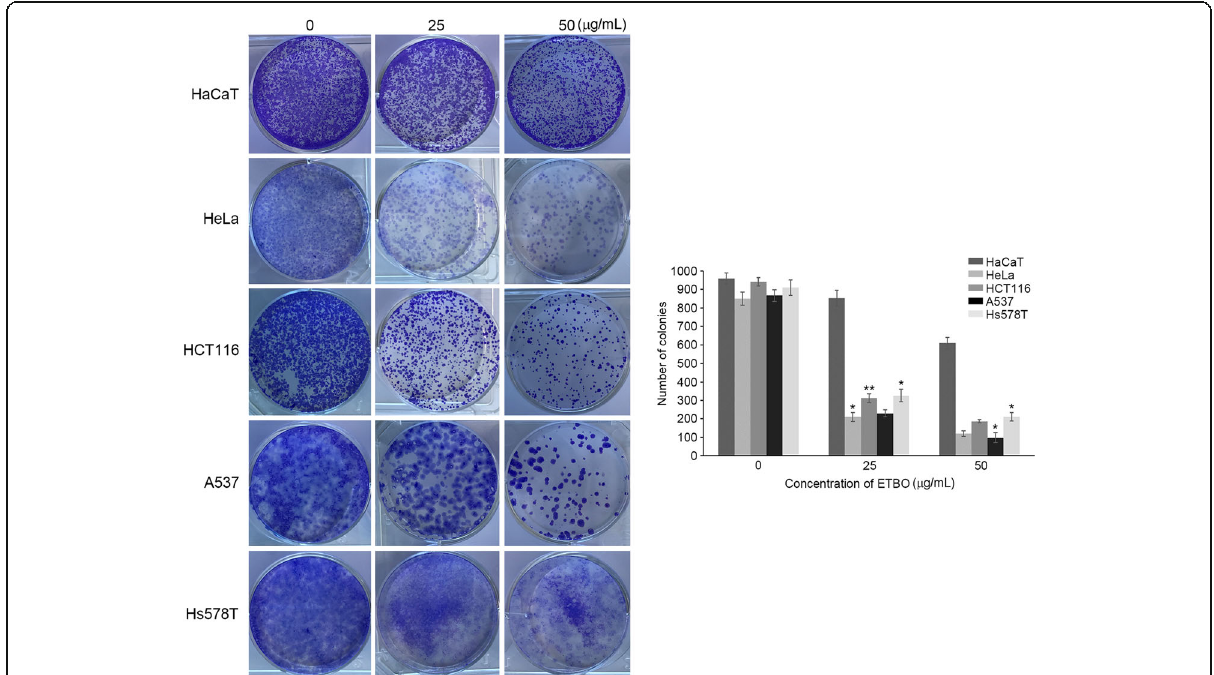
Fig. 3 Inhibition of colony formation of cancer cells after ETBO (25 and 50 μ g/mL) treatment for 12 h. Experiments were performed three times and the data are presented as the mean ± SD. * p < 0.05, ** p < 0.01 between the control and ETBO-treated